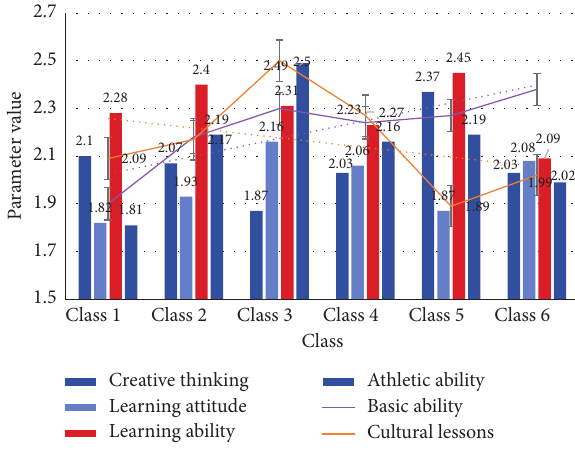
Figure 3: Boys’ learning status. Table 2: Art mastery of female students.